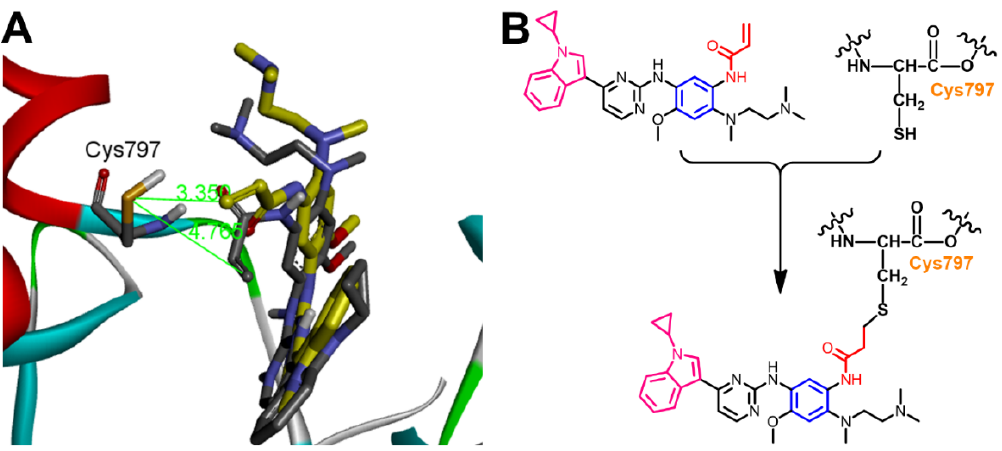
Figure 14. ( A ) 3D view of almonertinib (sown as sticks colored by element) overlaid with the co-crystallized osimertinib, showing the distance between the β -carbon of Michael acceptor sites and the thiol group of Cys797; ( B ) proposed mechanism of the covalent interaction between almonertinib and EGFR.